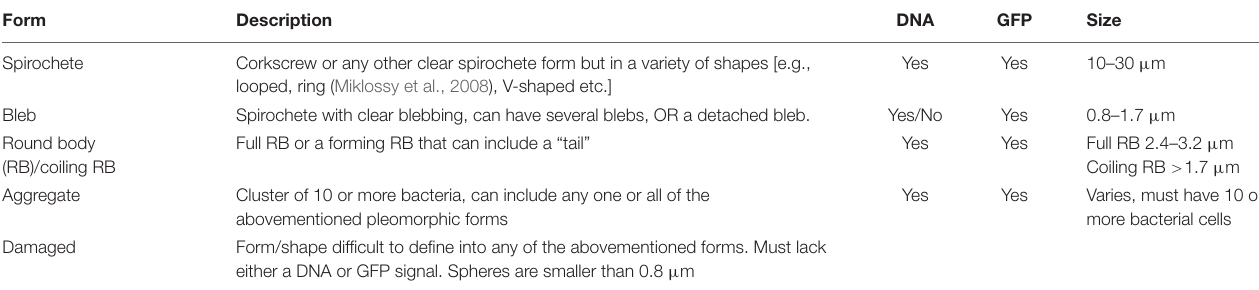
TABLE 1 | Pleomorphic forms of Borrelia burgdorferi and their characteristics. Form